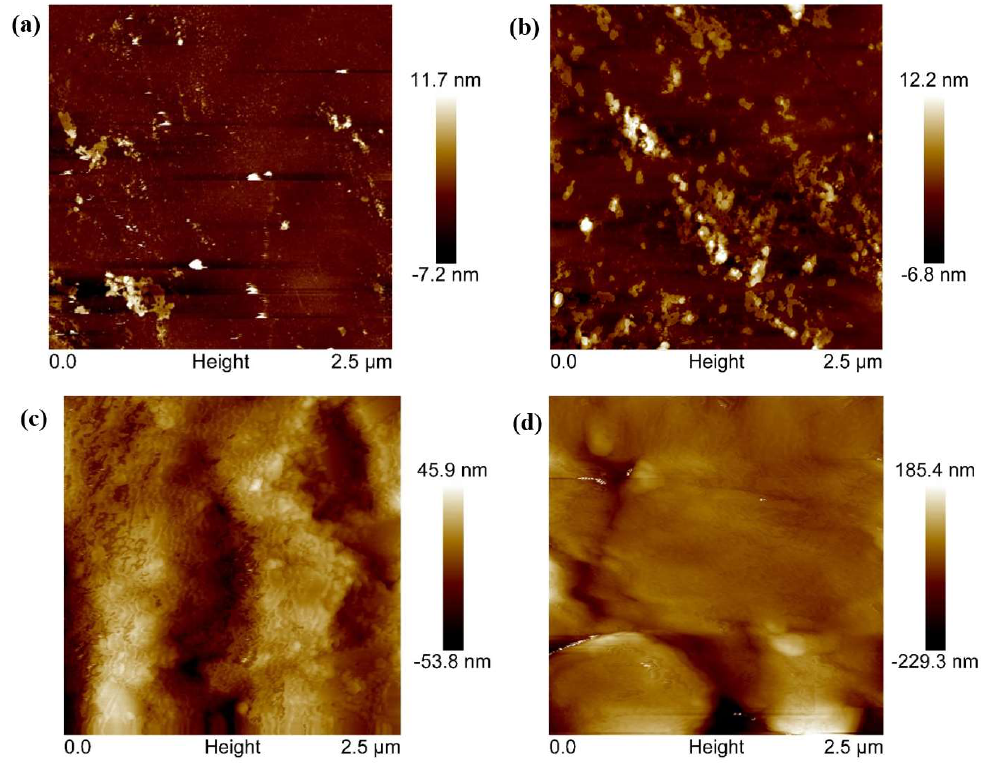
Figure 8. Atomic force microscopy (AFM) height images of mineral substrates. ( a ): freshly cleaved chalcopyrite surface, ( b ): Chalcopyrite surface treated with PBX, ( c ): freshly cleaved talc surface, ( d ): talc surface treated with PBX.